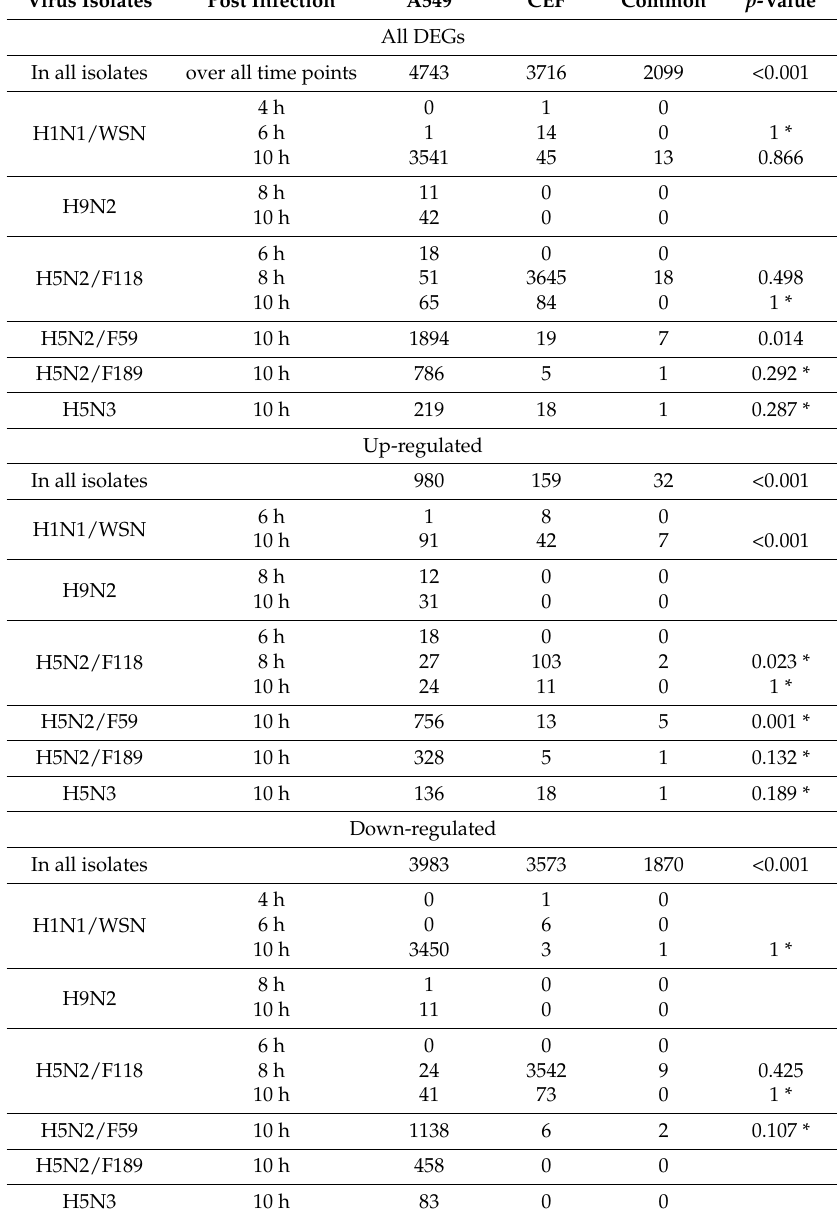
Table 4. Comparison of ortholog DEGs in IAV infected A549 and Chick embryo fibroblasts (CEF) cells. Virus Isolates Post Infection A549 CEF Common In all isolates over all time